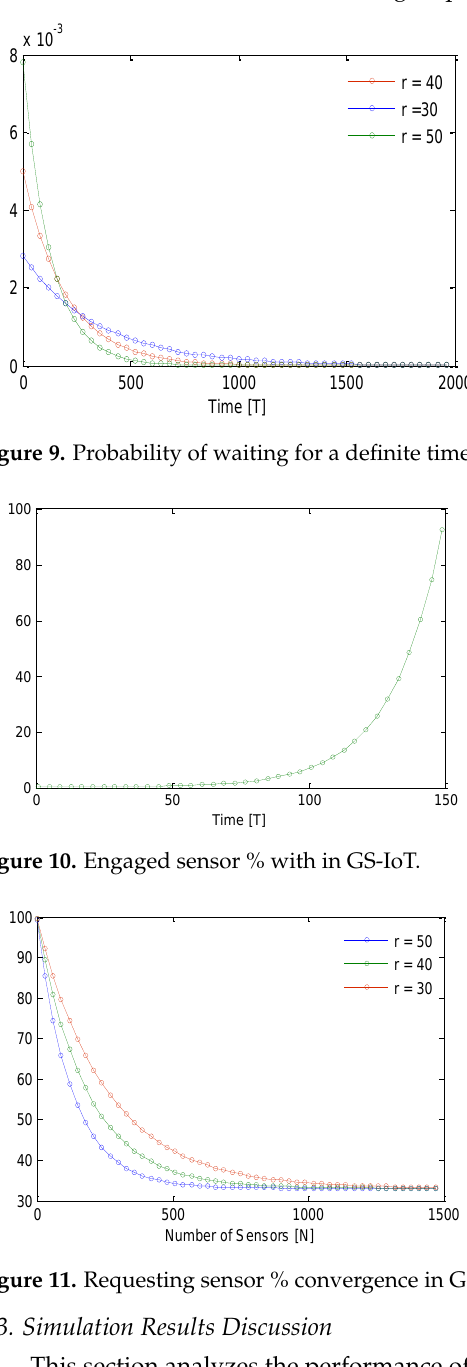
Figure 8. Probability of waiting for a finite time for the HelloReq packet.